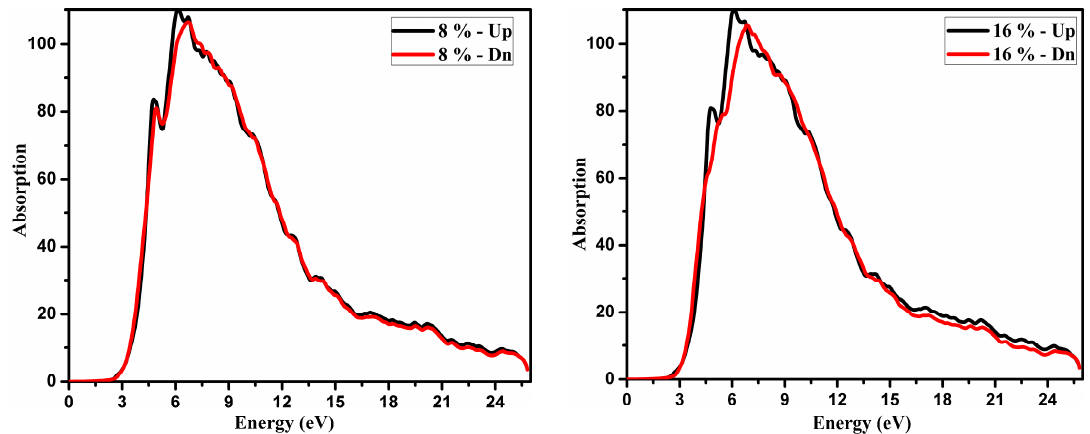
Figure 7. Calculated absorption spectrum (long solid curve ‐ black color for up) and (long solid curve ‐ red color for down) spectra for Mn x Zn 1 − x Te (x = 8% and 16%) crystals.